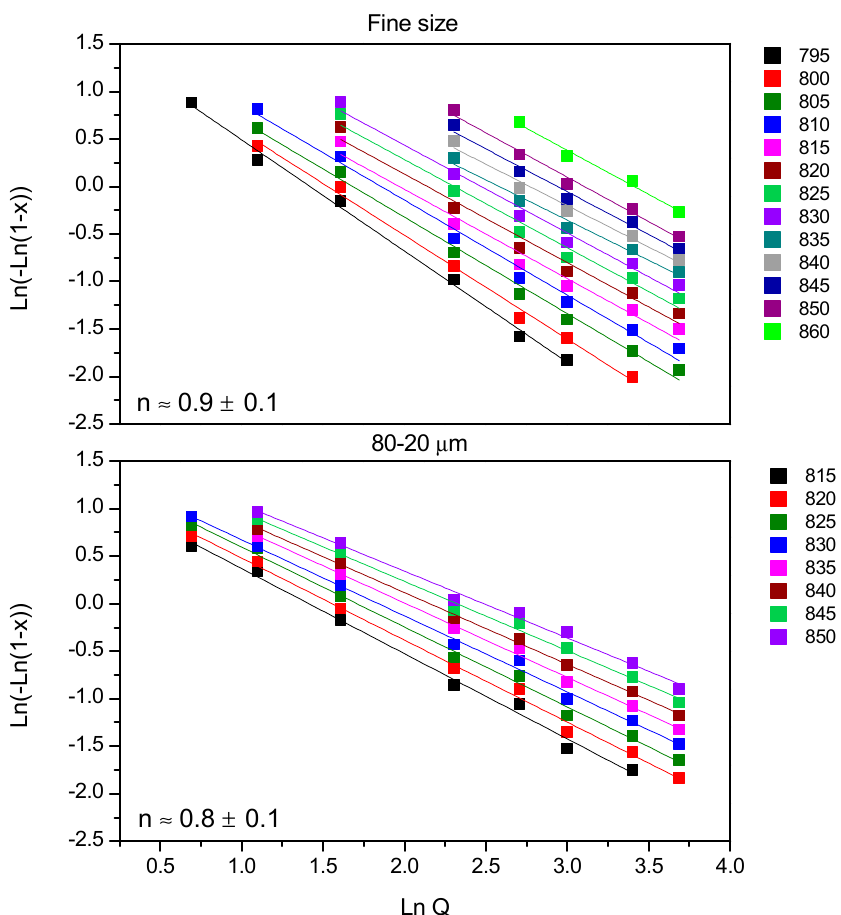
Figure 4. Determination of the n parameter from Ozawa representation for 7.5B(Ba) glass.